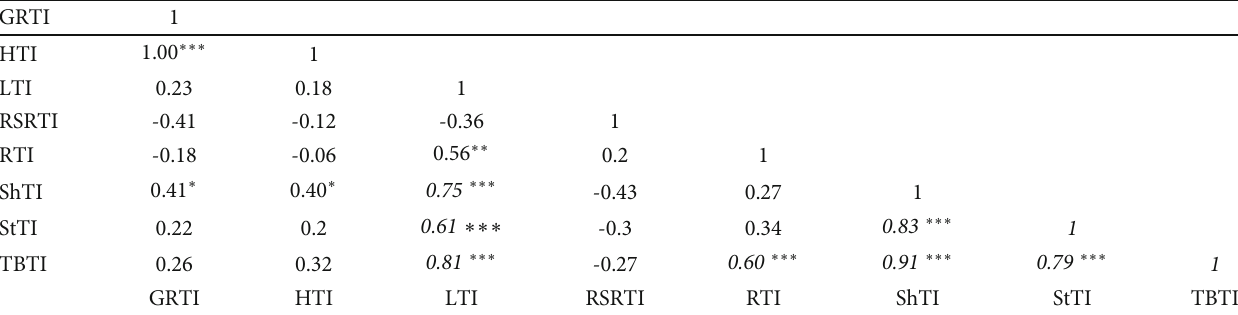
Table 7: Correlations among Striga resistance parameters.